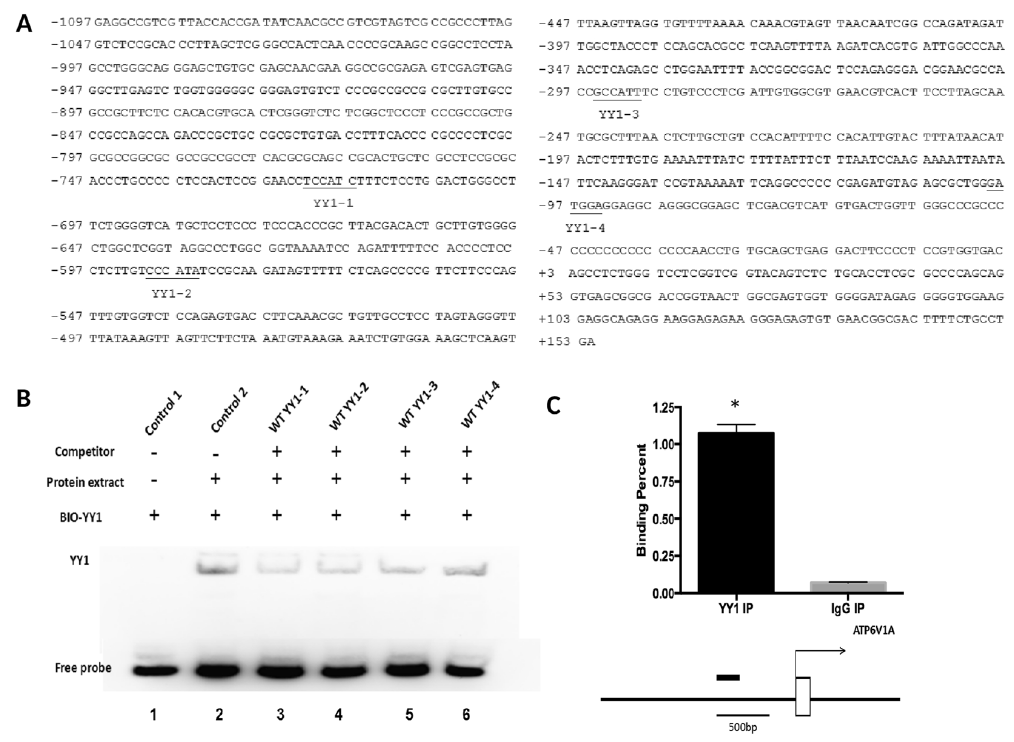
Figure 3. Identification of the YY1 binding sites in the ATP6V1A promoter. ( A ) The nucleotide sequence of the human ATP6V1A gene from − 1097 to + 13 bp. The putative transcription factor YY binding sites are underlined. ( B ) Excessive unlabeled oligonucleotide with the same sequence as the probe effectively competed with the probe binding by the YY1 protein and decreased its binding affinity, at a concentration of 50 times higher than the probe. In the 4 putatively predicted YY1 binding sites within the ATP6V1A promoter region, YY1-1, YY1-2 and YY1-3 oligonucleotides competed with the probe binding with YY1 at a concentration of 25 times higher to the probe, thereby significantly reducing the band intensity of DNA-protein complex of the probe with the YY1 protein in the lysate. ( C ) Chromatin immunoprecipitation (ChIP) assay for the YY1 binding to the ATP6V1A promoter. Left panel: Products of YY1 could be amplified in the co-immunoprecipitation with an anti-YY1 antibody, but not in the negative control samples containing a normal IgG, both of which were statistically different. Right panel: Schematic presentation of the region relative to the ATP6V1A transcriptional start site used as primer to test YY1 specific